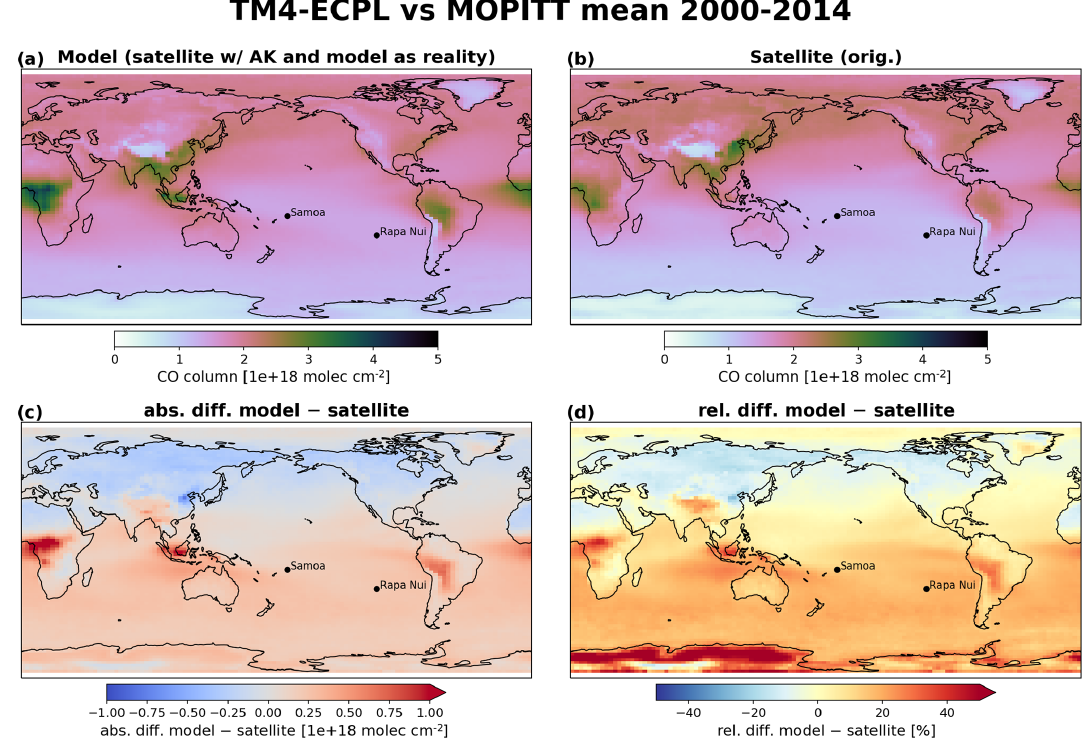
Figure 5. Model–satellite comparison between TM4-ECPL and MOPITT for CO total columns averaged from 2000 to 2014 (10 18 molec . cm − 2 ). (a) Modeled data sampled following the satellite track and the overpass times and averaged over the period, (b) satellite data averaged over the period, (c) absolute difference (1018molec . cm − 2 ), and (d) relative difference (%) between the mean values of model results and satellite in the 22km × 22km grids of MOPITT. The black dots show the locations of Samoa (left) and Rapa Nui